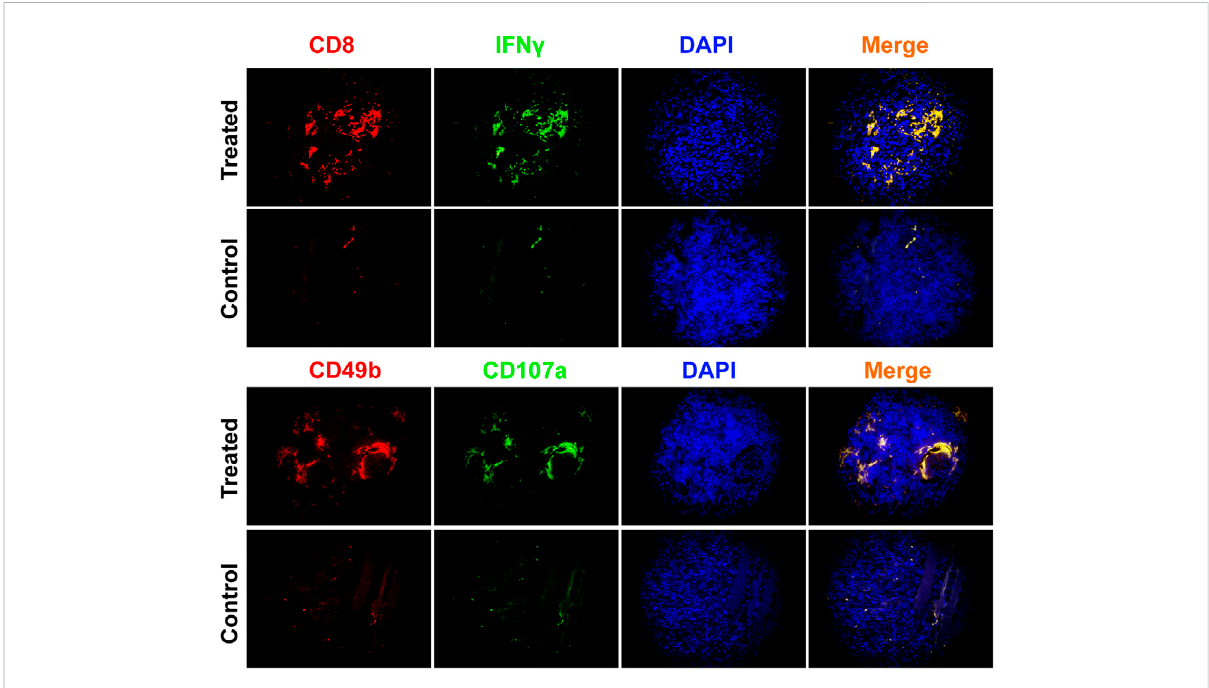
FIGURE 2 Immuno fl uorescence staining. In comparison to the control group, proportion of CD8+/IFN γ + cells, and CD49b+/CD107a+ cells in tumor tissues belonging to the CHMACS-treated group was signi fi cantly